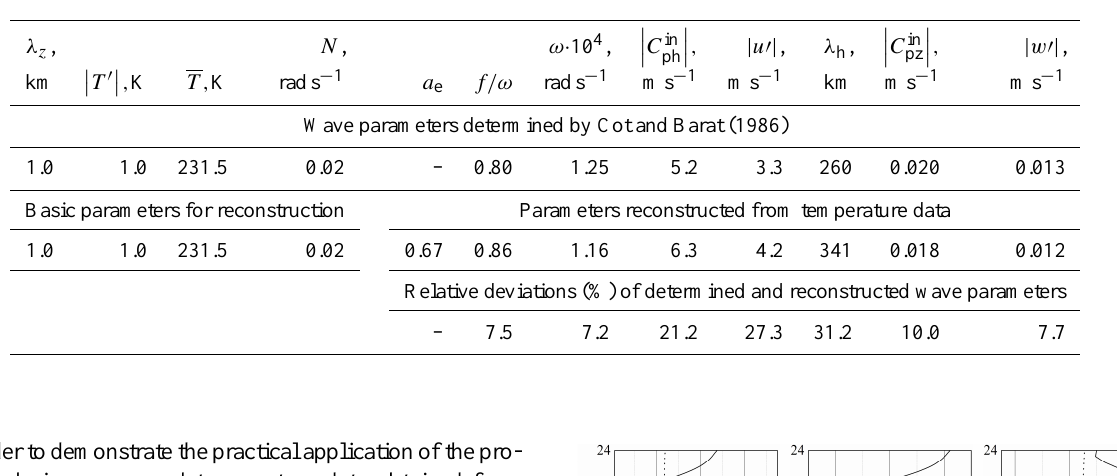
Table 1. Wave parameters determined by Cot and Barat (1986) using a wind speed hodograph analysis and those reconstructed from temperature data. Relative deviations between determined and reconstructed wave parameters are indicated.